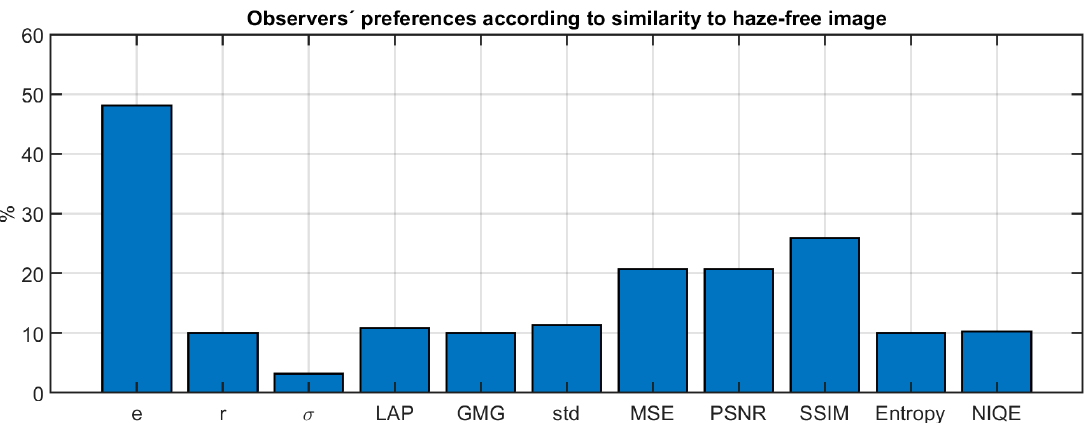
Figure 12. Percentage of agreement between the algorithm selected as best according to the observers’ answers to question 1 of the survey and the di ff erent metrics answers to question 1 of the survey and the different metrics analyzed.